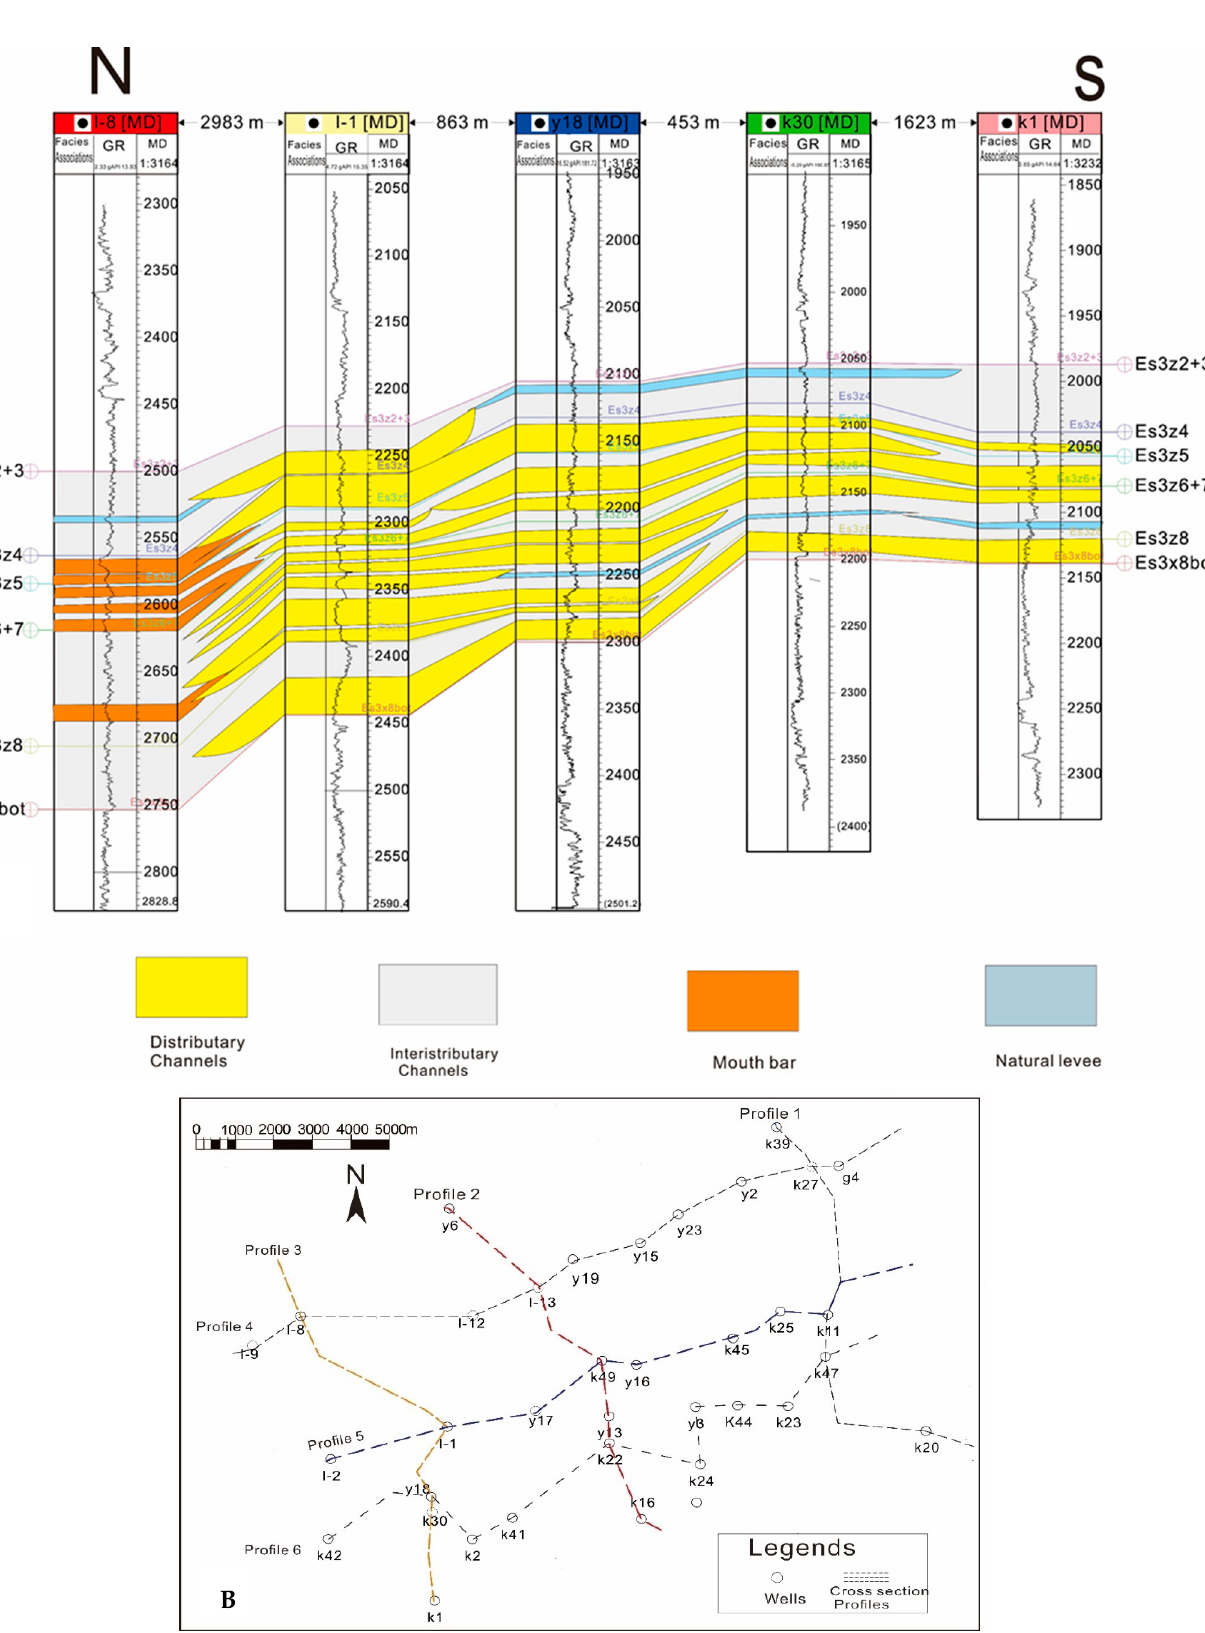
Figure 15. Cross section profile 5 of facies associations in five sandstones groups. showing facies to facies correlations from east to west direction.